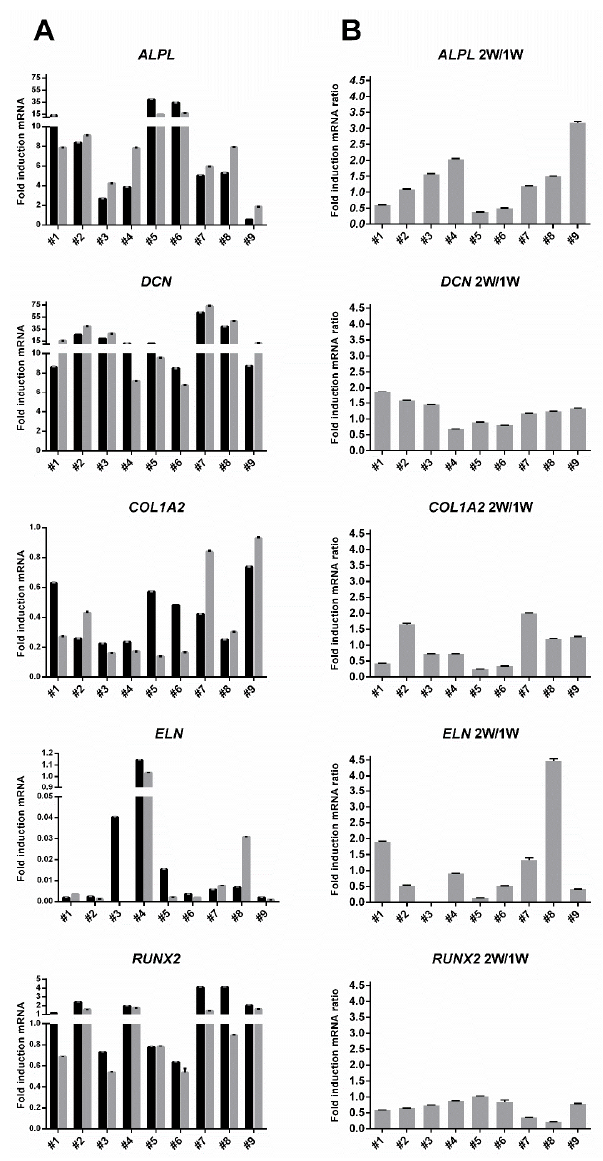
Figure 5. Inter-donor heterogeneity for fold increase in osteogenic signature gene induction against corresponding non-induced hMSC derived from donors #1–#9 detected by the SYBR Green method. Histograms of column ( A ) indicate the level of named gene upregulation in response to osteogenic medium treatment for 7 days (black bars) or 14 days (grey bars). Histograms of column ( B ) indicates the ratio between fold increase values at two weeks (2W) and one week (1W). Interpolation used GUSB / YWAHZ reference genes. Inter-assay variability is shown by error bars indicating the pooled coe ffi cient of variation ( p <